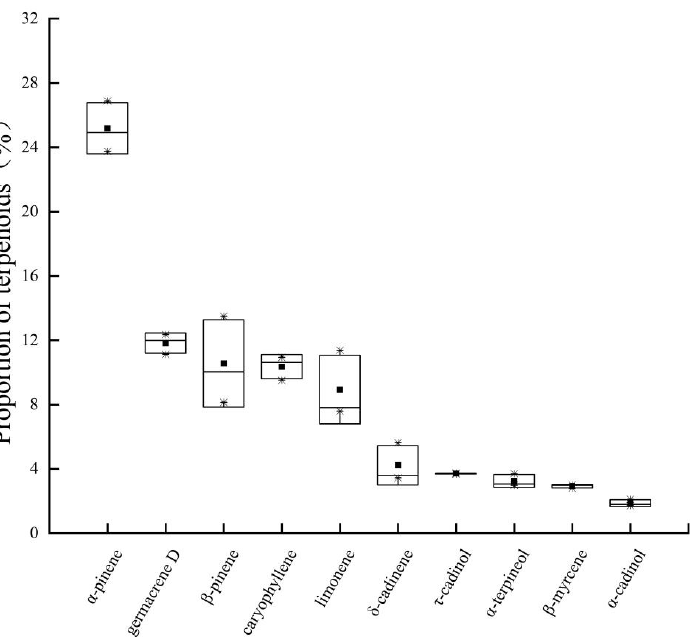
Figure 3. Ten most abundant terpenoids in the volatile oil from live branches. (The top and bottom asterisks indicate the maximum and the minimum, respectively. The top and the bottom lines in the boxes indicate the upper and the lower quartiles, respectively. The lines within the boxes indicate the median lines, and the solid square indicate the mean